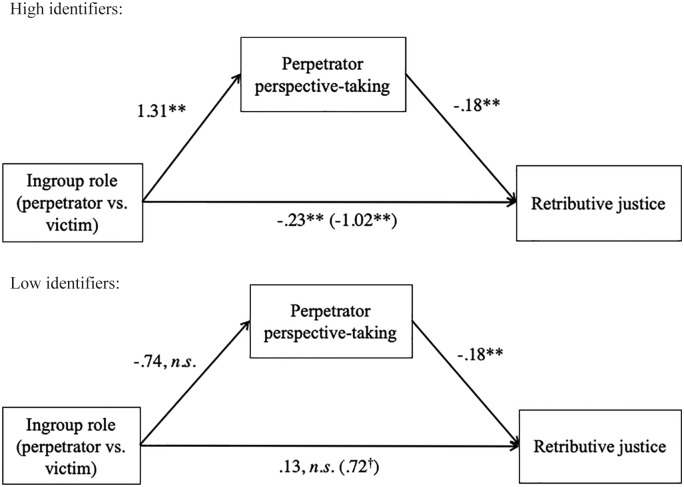
Moderated mediation models for high and low identifiers (Study 1).Note. All coefficients are unstandardized.